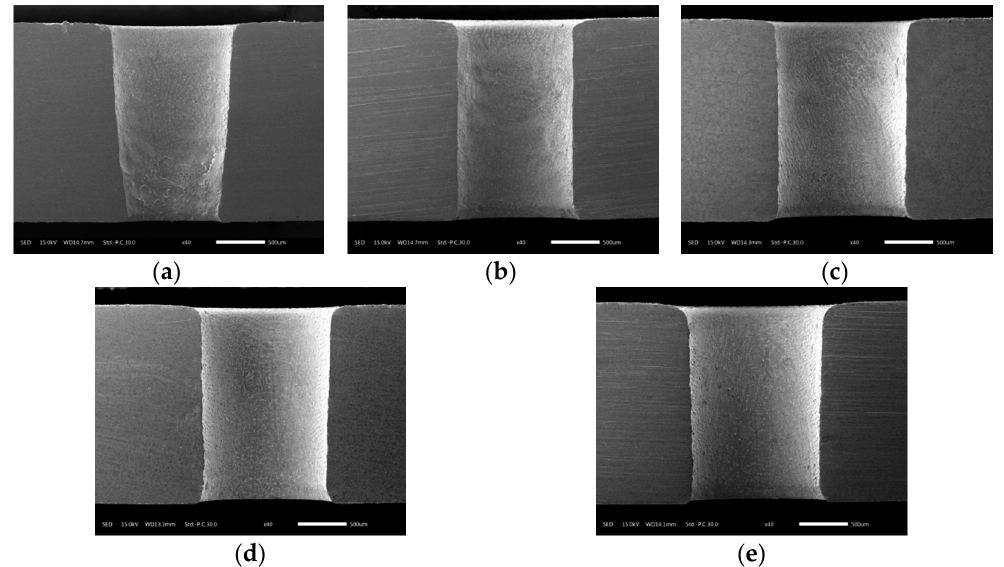
Figure 18. Sectional views of holes at different electrolyte concentrations in electrochemical reaming: ( a ) 2 g / L; ( b ) 4 g / L; ( c ) 6 g / L; ( d ) 8 g / L; ( e ) 10 g /